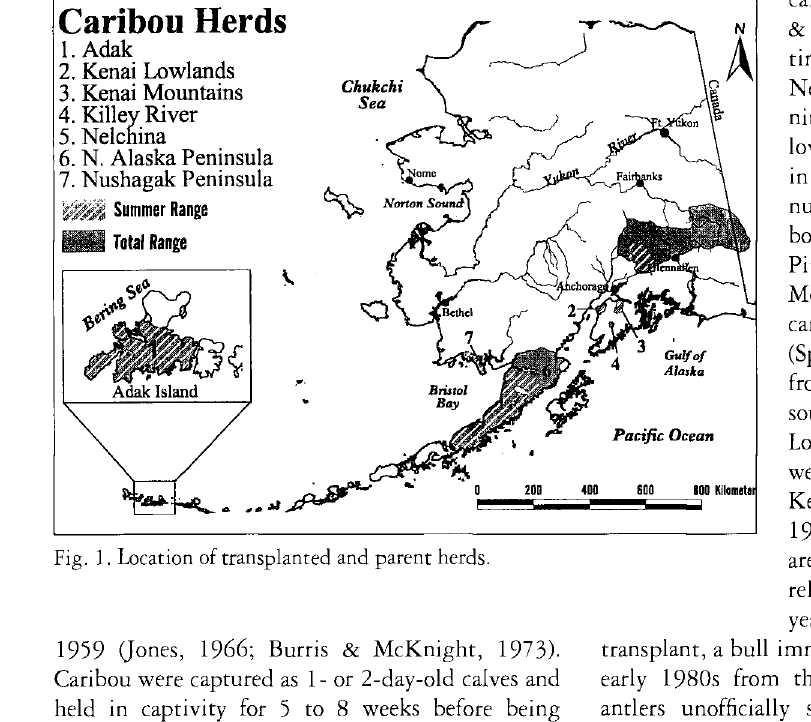
Fig. 1. Location of transplanted and parent